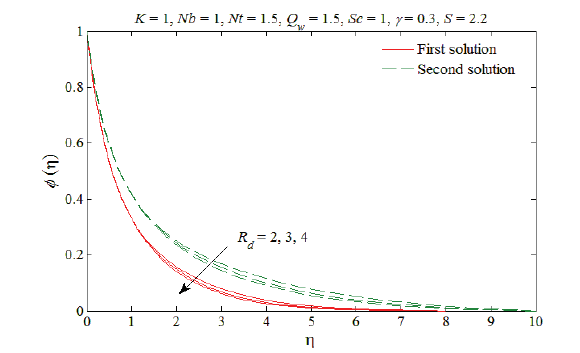
Fig. 7: The concentration profiles for different values of Nt .